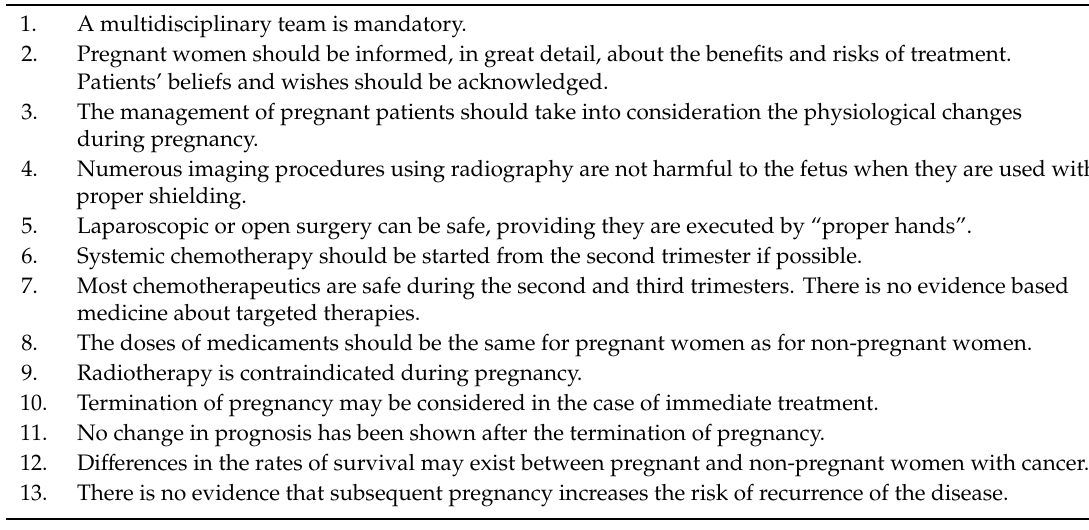
Table 6. Ovarian cancer during pregnancy: basic principles of